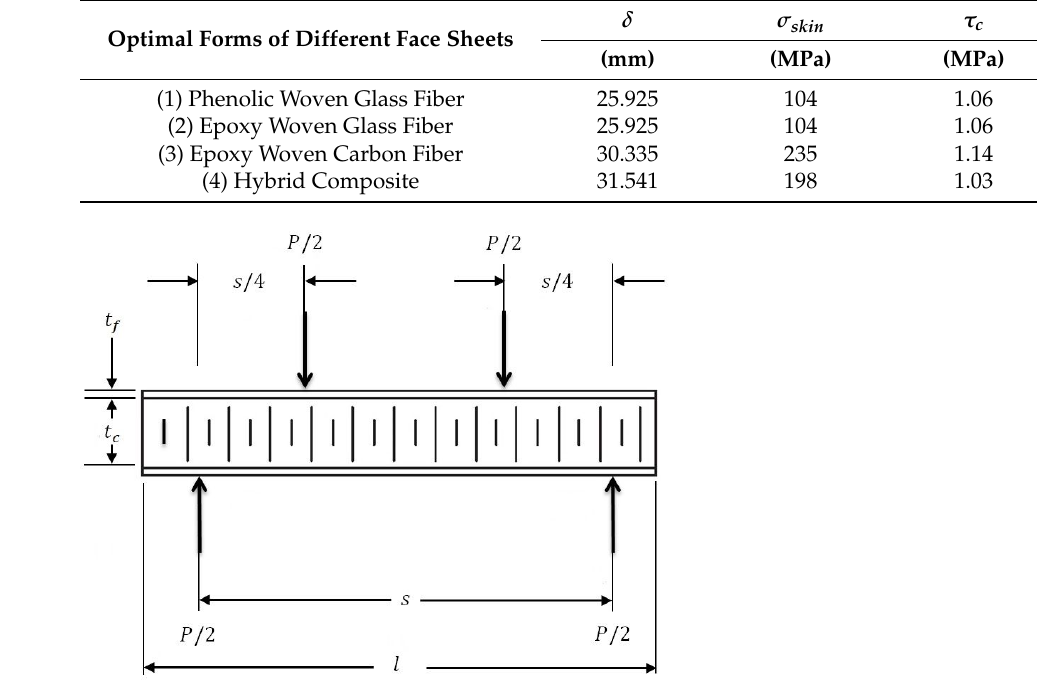
Figure 7. Four-point bending test setup of the honeycomb sandwich plate by the Digimat-HC pro- gram.